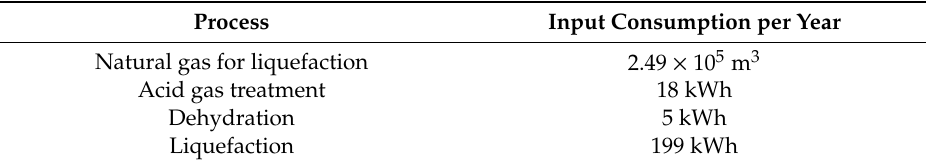
Table 3. Material and energy flow.